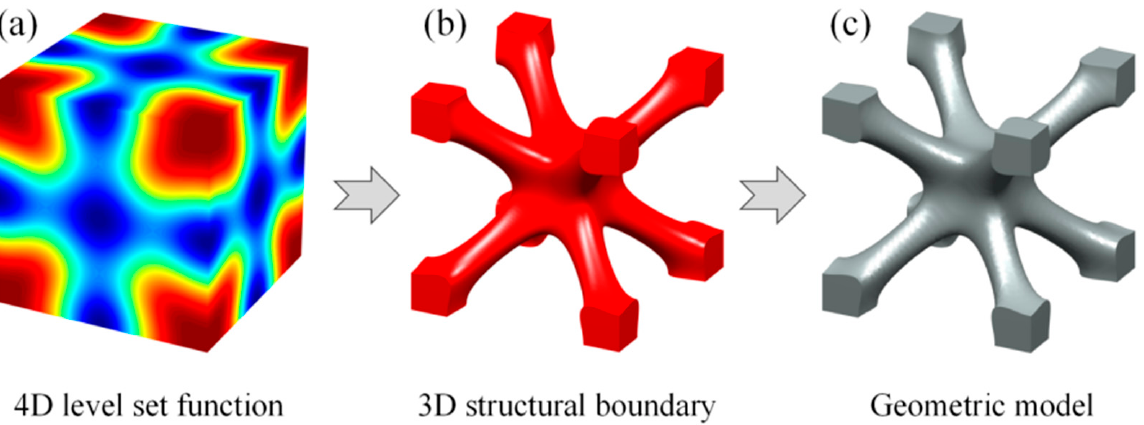
Figure 1. Implicit modeling based on LSF and 3D geometric model. ( a ) The LSF. ( b ) Contour of zero level set. ( c ) 3D geometric model.